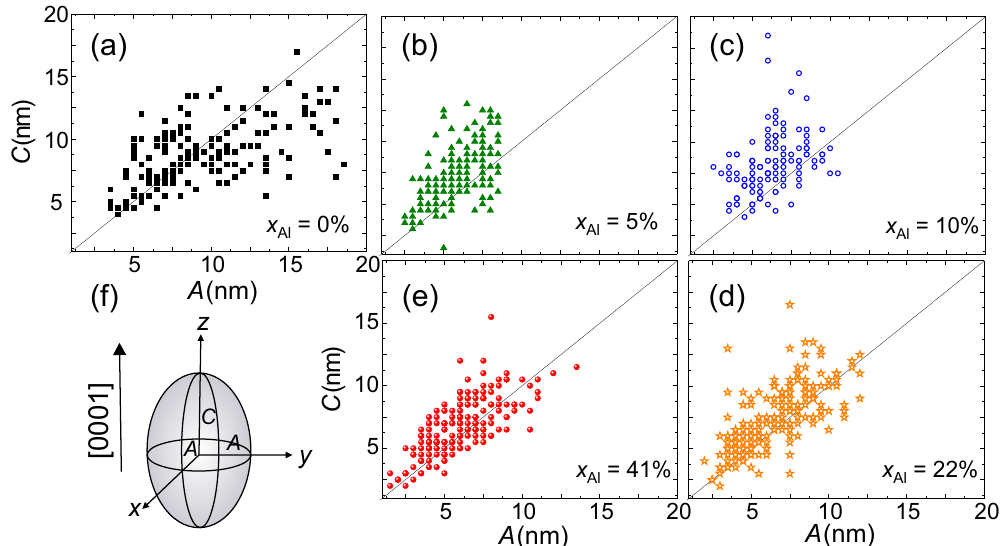
Figure 4. Size distribution of 200 NCs measured in cross-section HRTEM for x Al in the buffers equal to: ( a ) 0%, ( b ) 5%, ( c ) 10%, ( d ) 22%, and ( e ) 41%. The dimensions A and C correspond to the schematic representation depicted in ( f ) and correspond to half the size perpendicular and parallel to the [ 0001 ] growth direction,